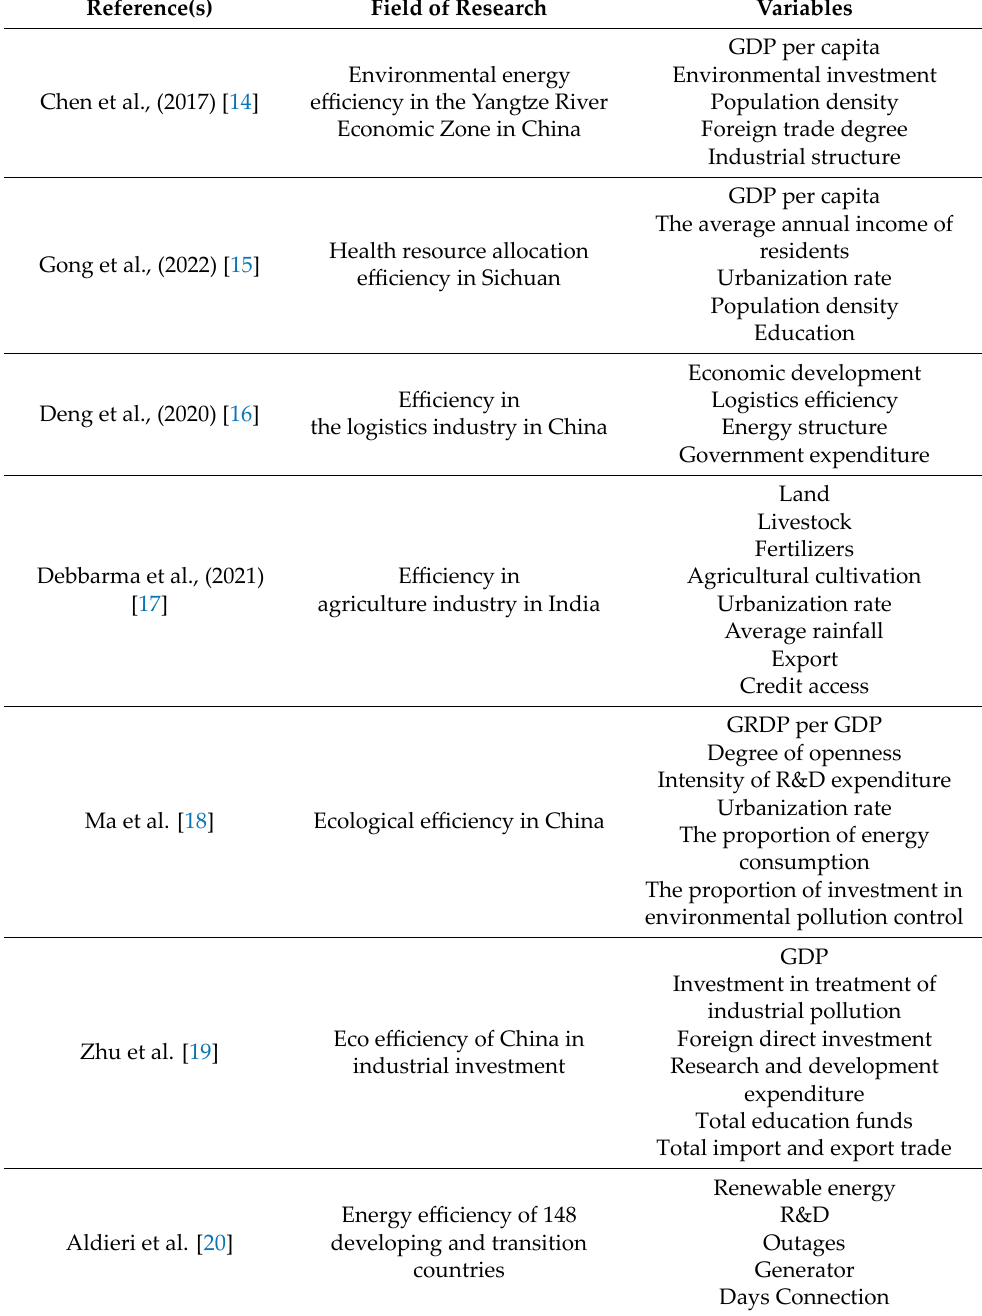
Table 2. Research on the application of Tobit